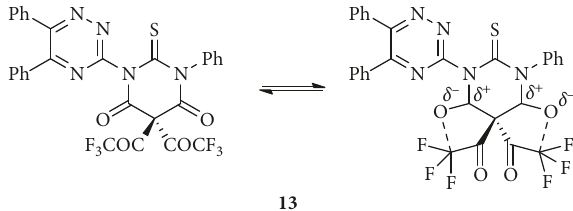
Figure 3: Stable bioconjugated system of compound 13